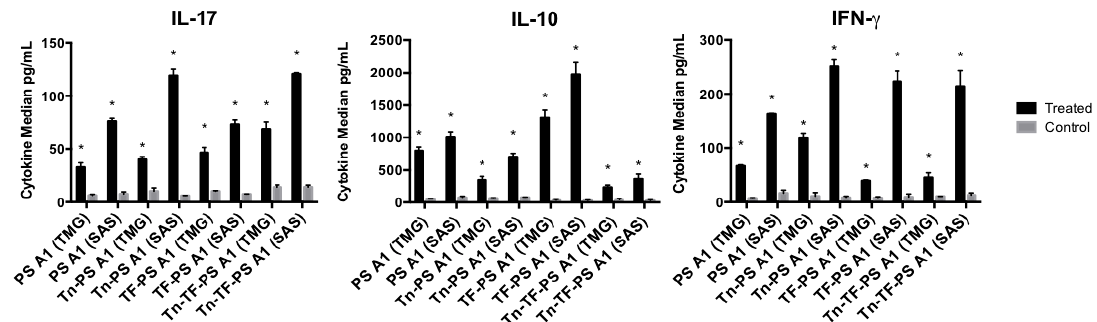
Figure 4. IL-17, IL-10, and IFN- γ in vitro cytokine production assay from stimulated murine splenocytes. PS A1 and TACA-PS A1 constructs were used as stimuli. The cytokines were detected using sandwich ELISA and experiments were performed in triplicate. Error bars are shown as mean ± standard error of mean. Where * p < 0.05 was obtained by using two-tailed Student’s t -test.